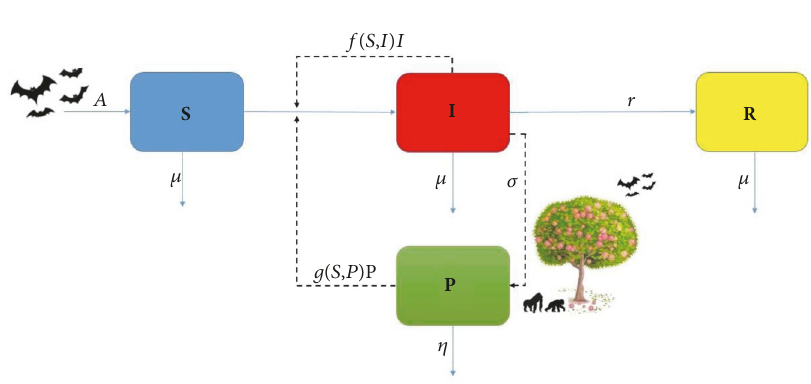
Figure 1: Schematic representation of model